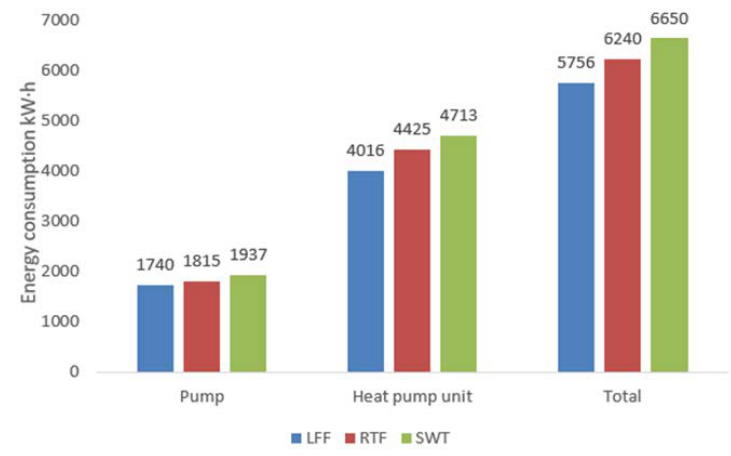
Figure 14. Comparison of energy consumption under three